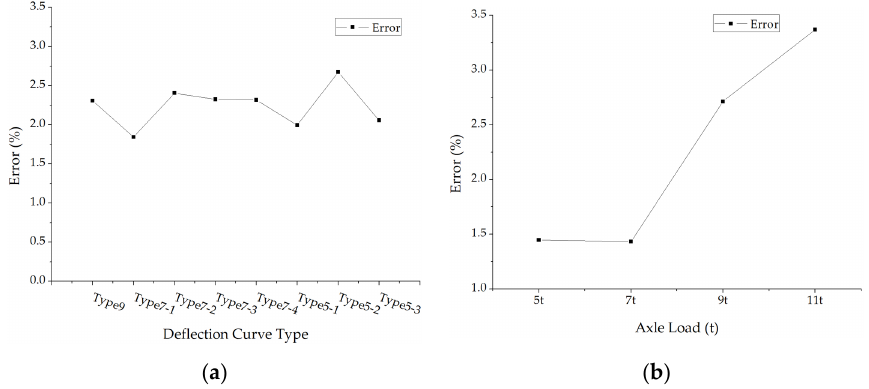
Figure 7. The errors of back calculated base modulus under different deflection curve types: ( a ) Structure 1; ( b ) Structure 2; ( c ) Structure 3; ( d ) Structure 4; ( e ) Structure 5; ( f ) Structure 6.